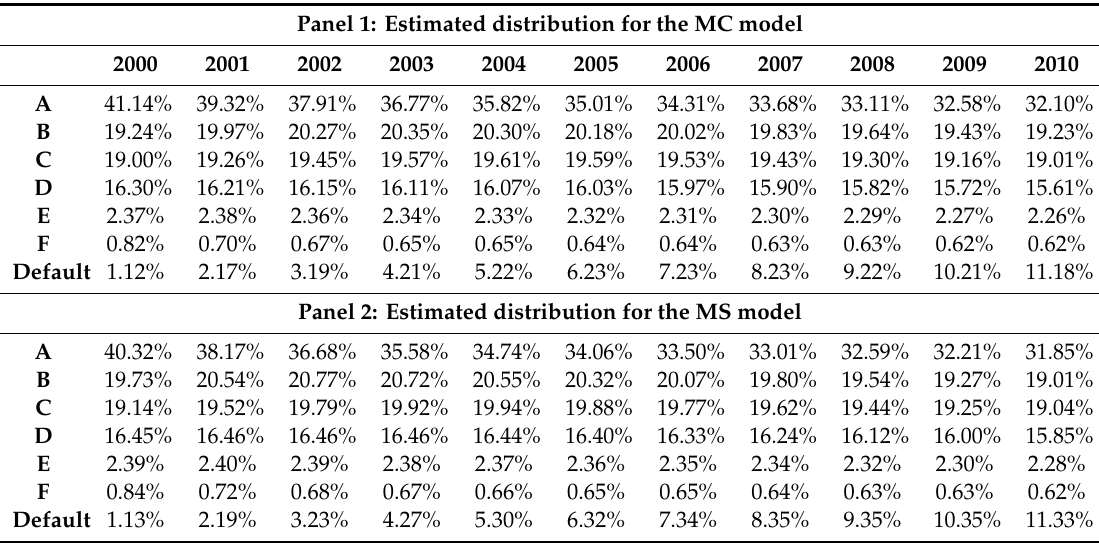
Table 5. Estimated distribution for the MC and MS models. Panel 1: Estimated distribution for the MC